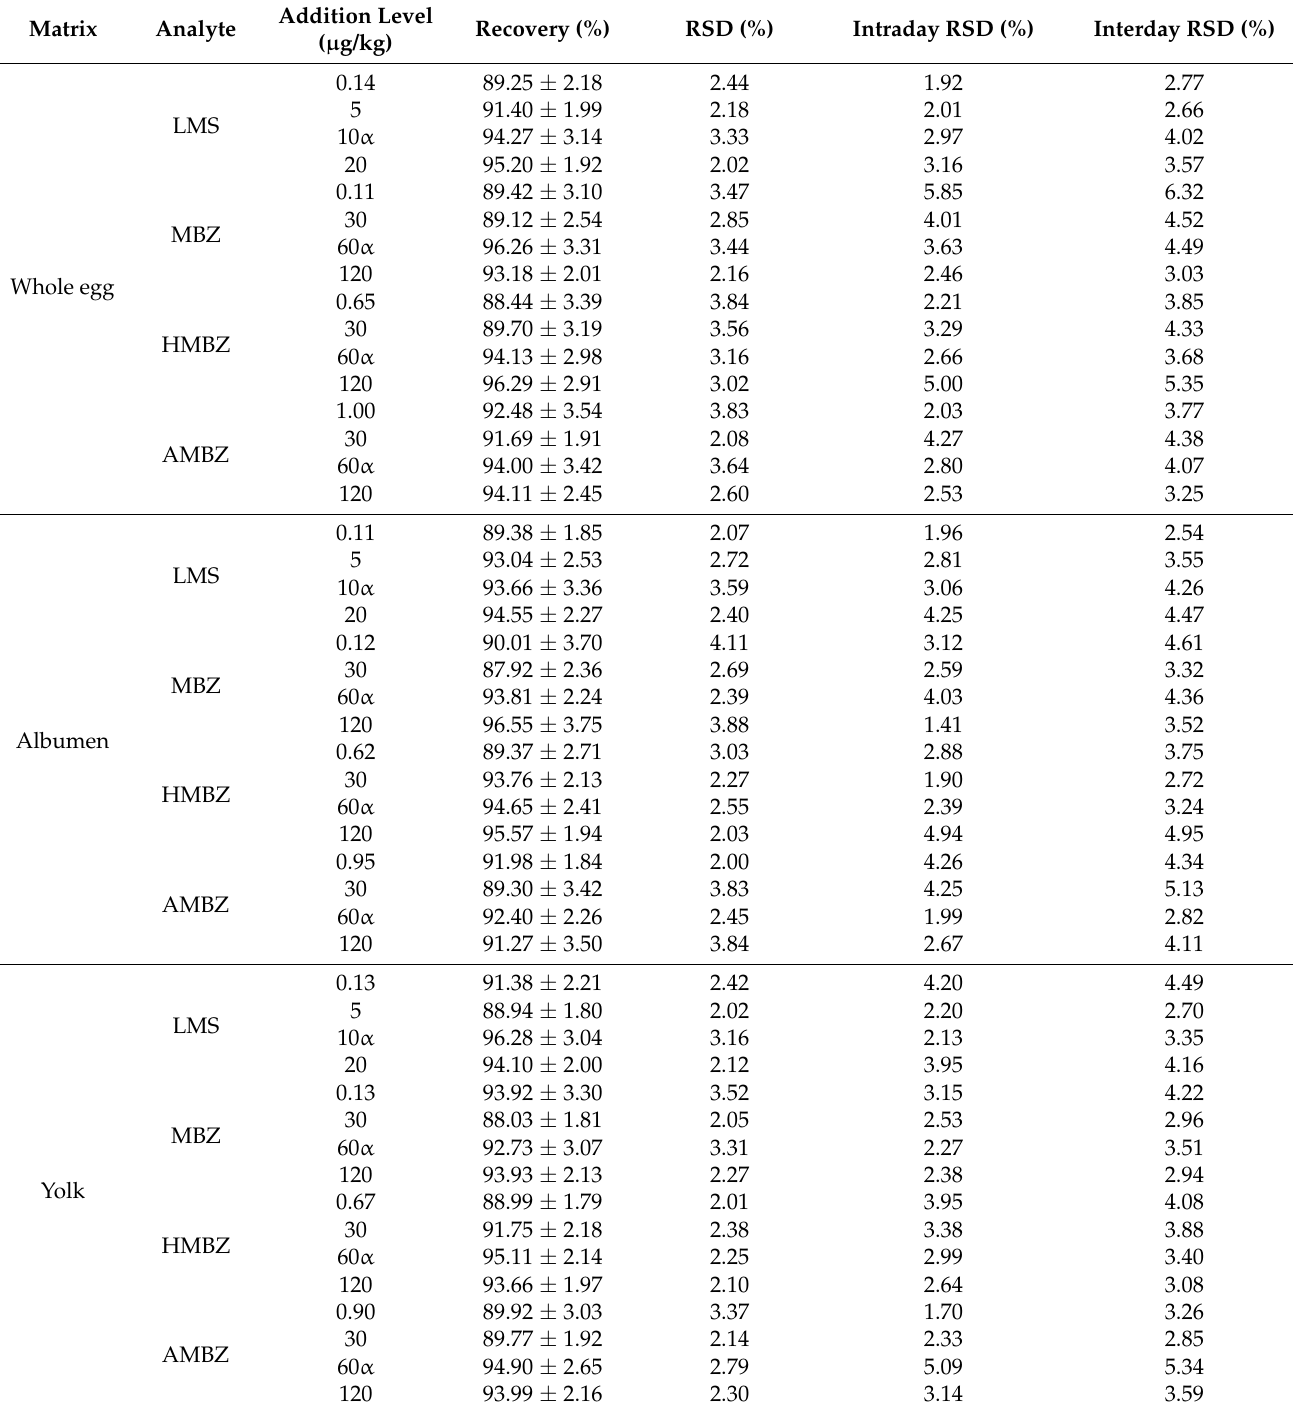
Table 6. Recovery and precision of LMS, MBZ, HMBZ, and AMBZ added to blank duck eggs ( n =